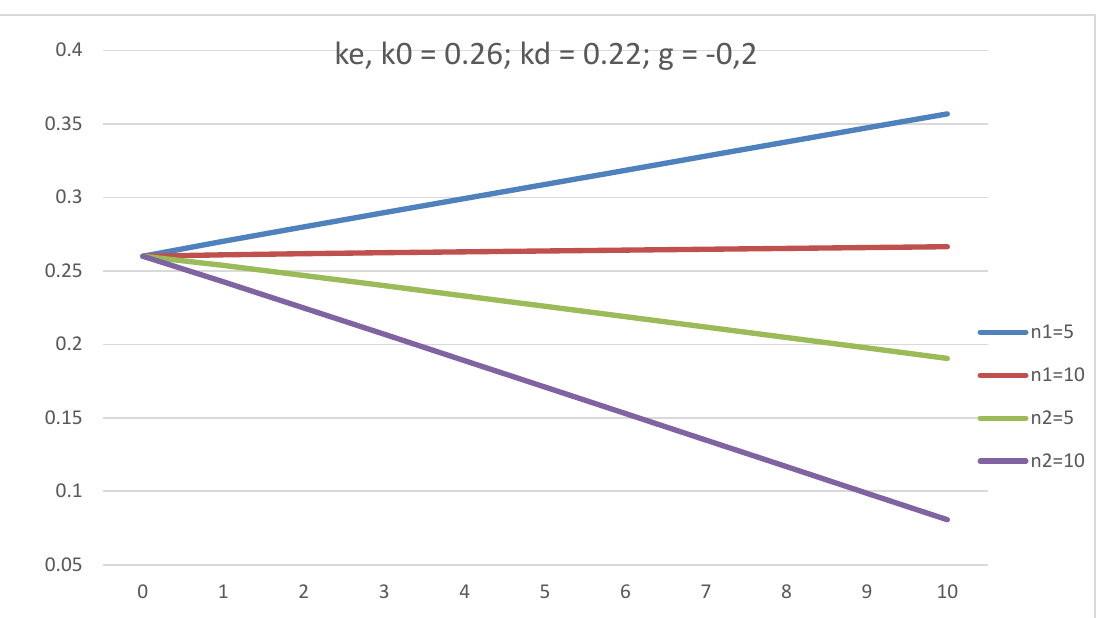
Figure 15. The dependence of equity cost, ke, on leverage level, L, in GBFO theory with payments of tax on profit at the end of periods (1) and advance payments (2) at k 0 = 0.26; k d = 0.22; t = 0.2; g = − 0.2, for five-year and ten-year companies.